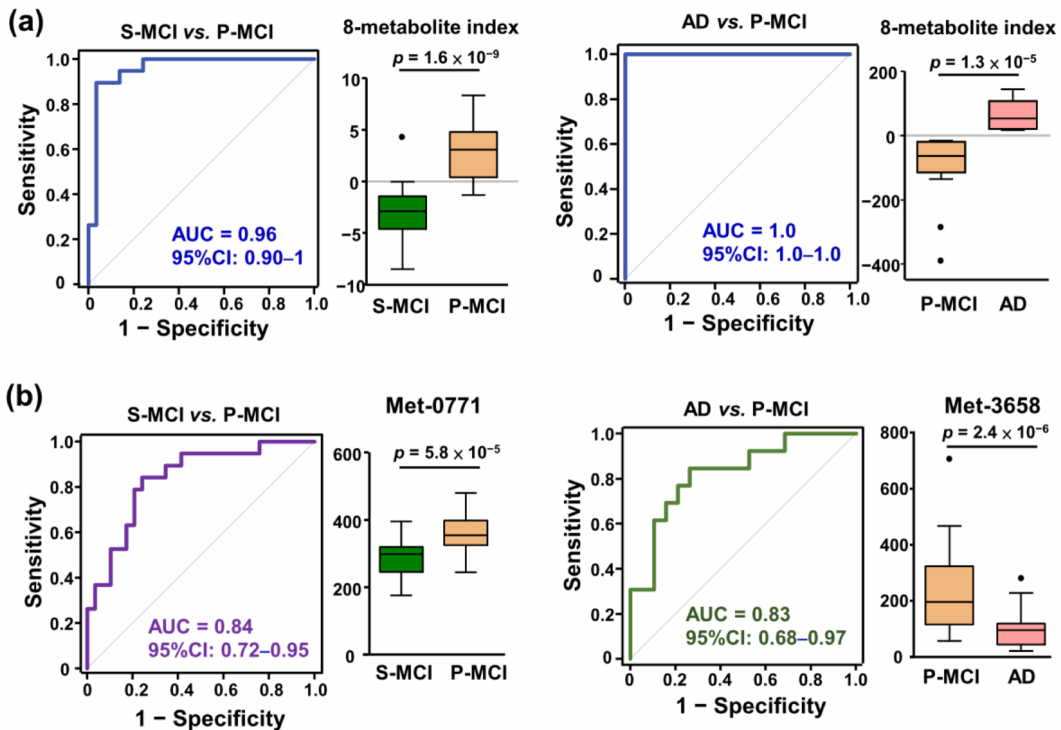
Figure 4. ROC curve analysis assessing the performance of the binary diagnostic tests using the various statistical and machine learning strategies. ( a ) ROC curves based on eight-metabolite index generated using the logistic regression model to discriminate between P-MCI vs. S-MCI groups and AD vs. P-MCI groups. The associated AUC and 95% confidence interval (CI) are indicated. ( b ) ROC curves based on univariate statistical significance to discriminate between P-MCI and S-MCI groups and the AD and P-MCI groups. The grey diagonal line represents random classifier performance (AUC = 0.5). Each metabolic feature and metabolite index is depicted in a vertical box plot where the horizontal lines represent the median value and the black dots represent the outliers (>1.5 interquartile range from ends of the box). Student’s t -test was used to assess the significance of the difference between two groups. AUC, area under the ROC curve. S-MCI, stable MCI; P-MCI, MCI proceeding to AD; ROC, receiver operating